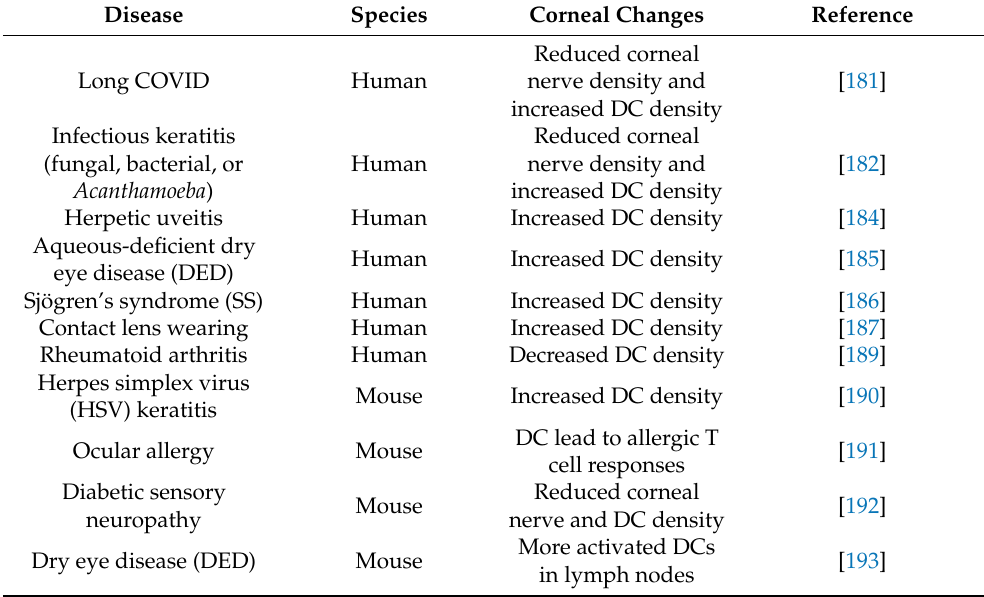
Table 1. Changes in Dendritic Cells (DCs) in ocular